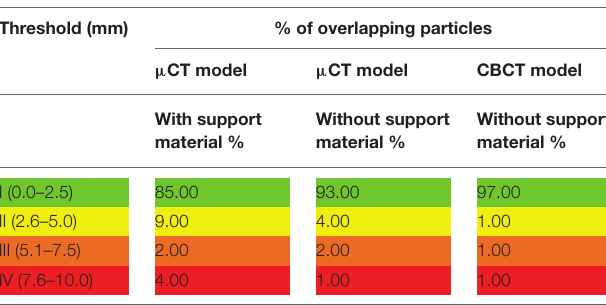
TABLE 1 | Results from the dimensional accuracy evaluation of the additively manufactured rabbit airway models using part comparison canalysis in Materialize 3-Matic 13.0 software before and after the removal of support material.